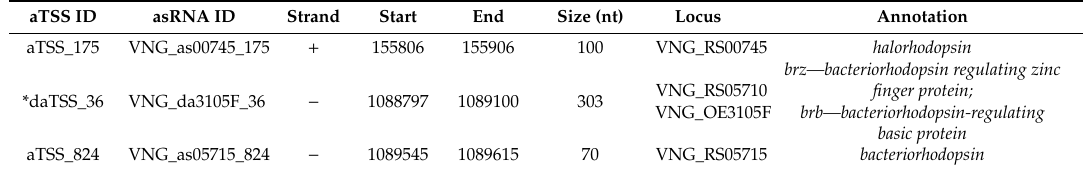
Table 2. asRNAs in rhodopsin related genes, located in the main